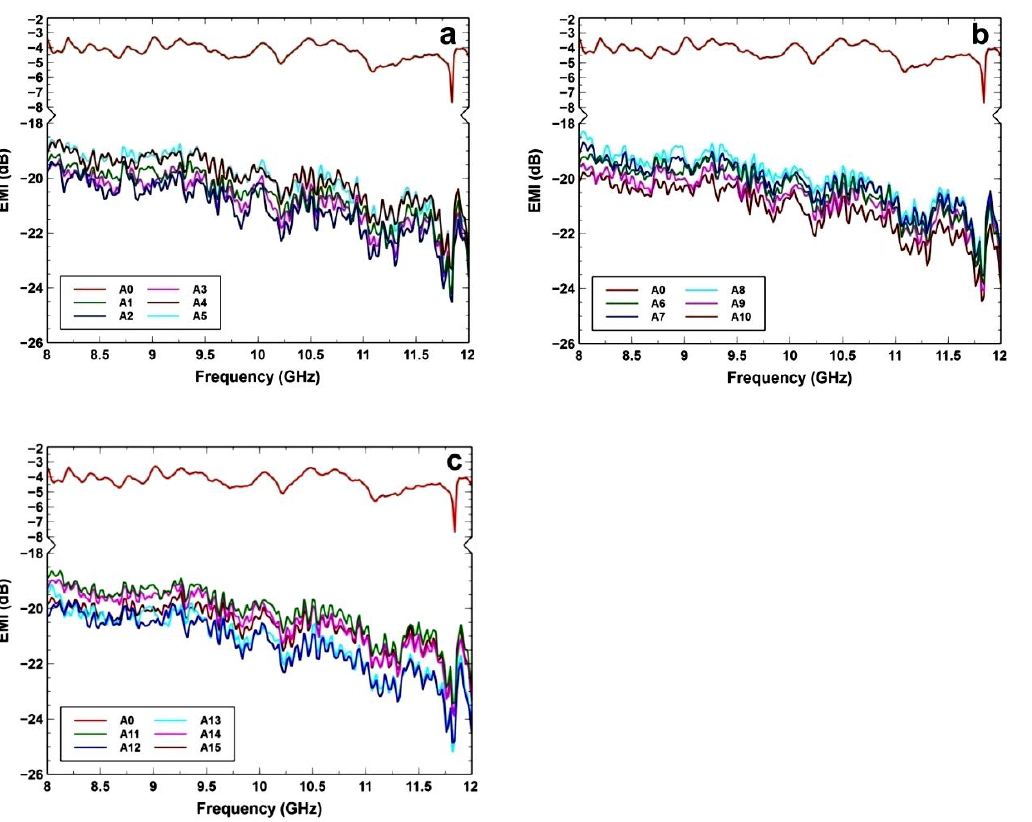
Figure 5. Evaluation of EMI values for ( a ) (A0, A1–A5), ( b ) (A0, A6–A10) and ( c ) (A0, A11–A15) of different flexible bio-based polyurethane foams with and without nanoparticle